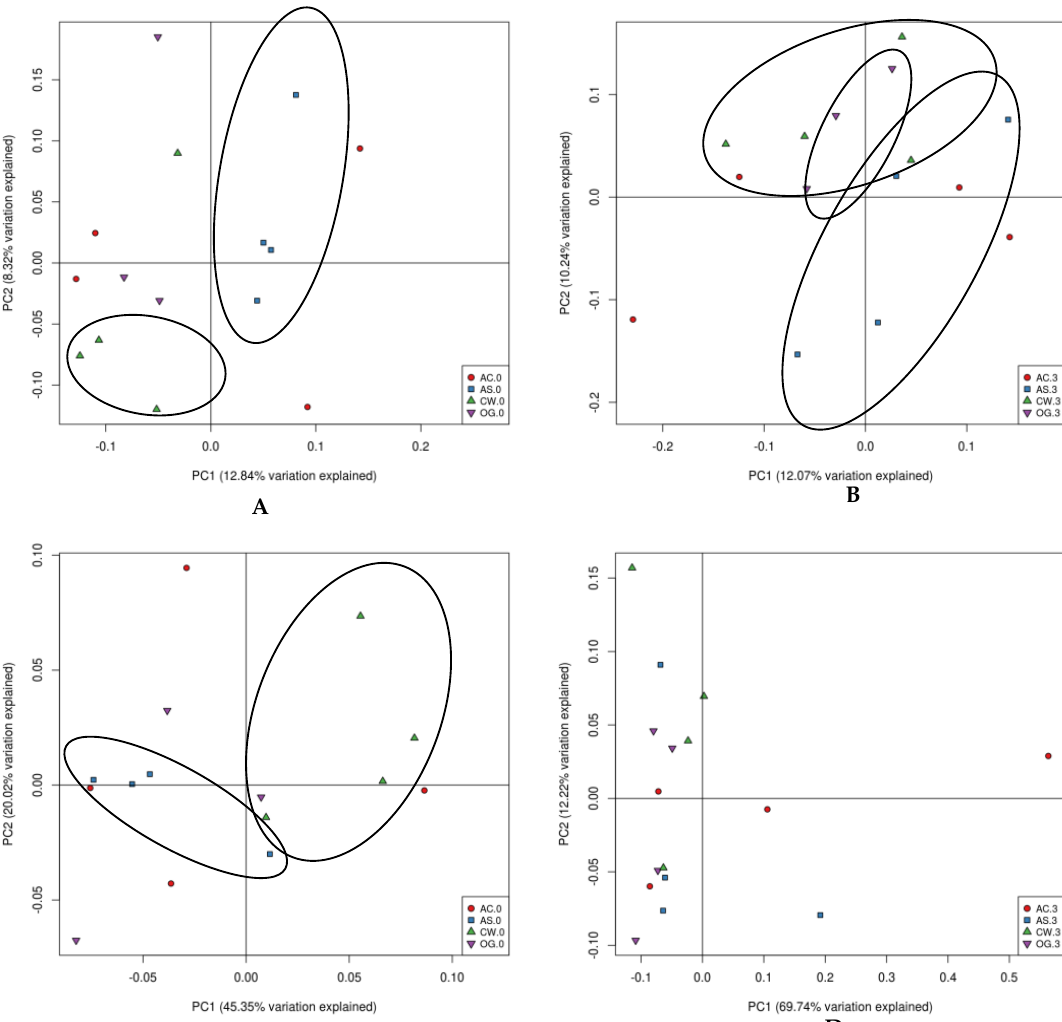
Figure 4. Principal coordinates analysis of rumen microbes with different treatment. (( A ) 0 h unweighted-unifrac-PCoA; ( B ) 3 h unweighted-unifrac PCoA; ( C ) 0 h weighted-unifrac PCoA; ( D ) 3 h unweighted_unifrac PCoA); The source and combination of the forage are the influencing factors, which serve as the abscissa and ordinate of PCoA analysis.